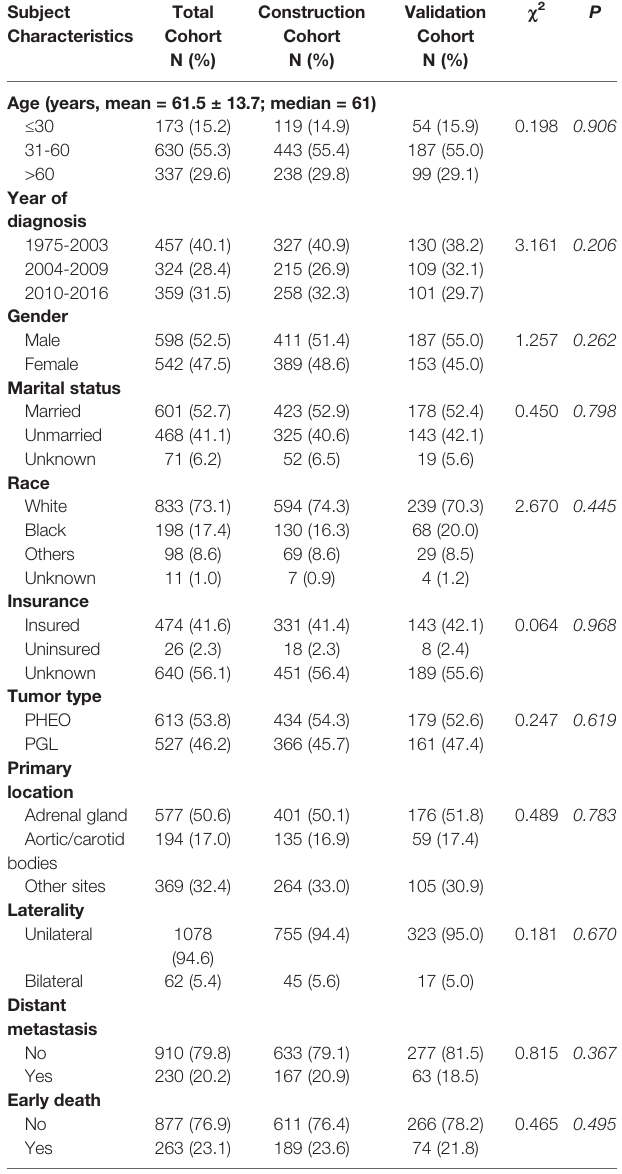
TABLE 1 | Demographicandclinicopathologiccharacteristics in the present